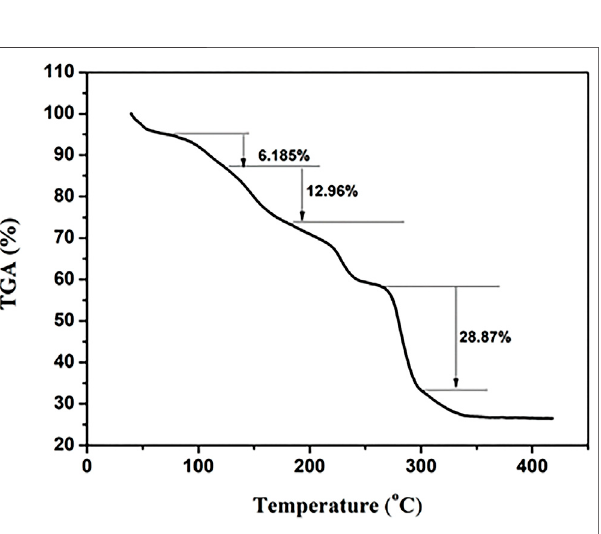
FIGURE 5 | Differential heat – heat weight map of